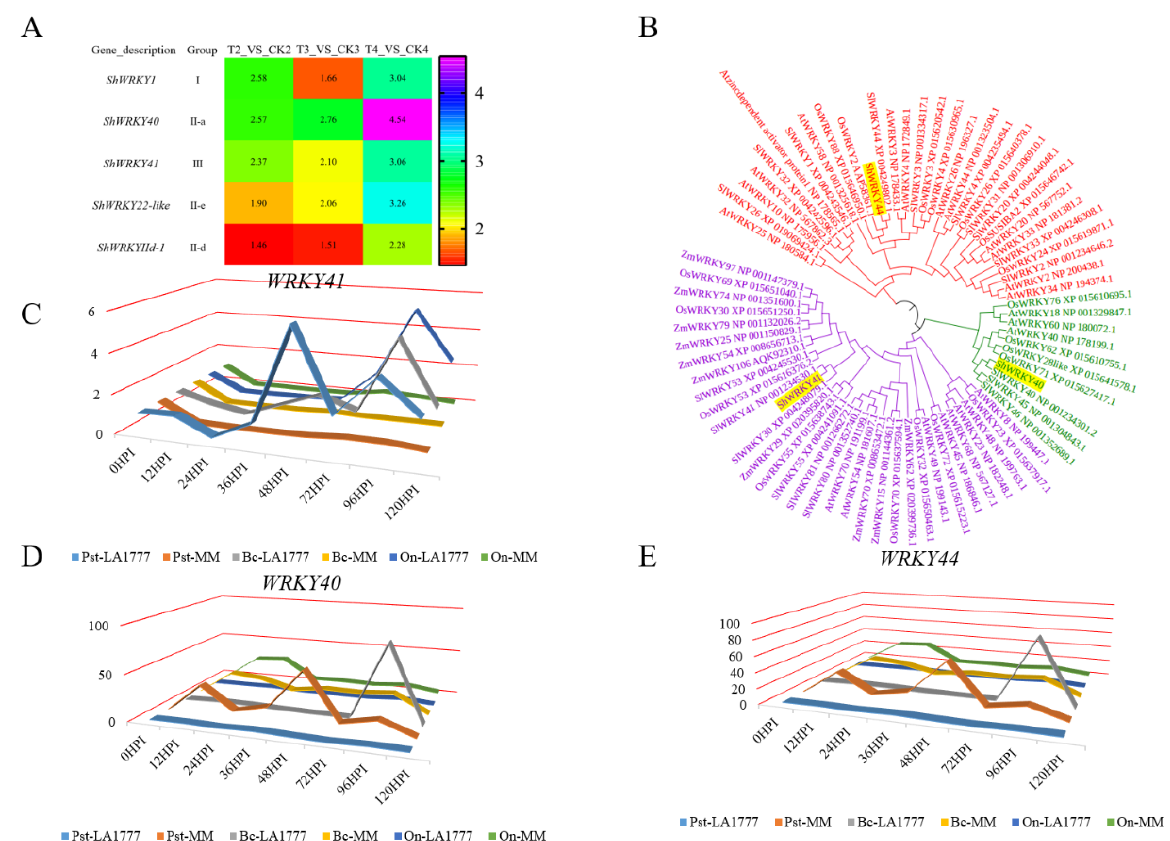
Figure 3. The screening and identification of WRKY41 . ( A ) The co-expressed WRKY genes among the RNA-seq analysis. ( B ) The result of phylogenetic analysis of WRKY40, WRKY41 and WRKY44 using NJ method with JTT model. ( C – E ) The result of WRKY40 , WRKY41 and WRKY44 relative expression levels in wild tomato LA1777 or cultivar tomato MM under Pst DC3000, On -lz and B. cinerea infection using qRT-PCR.